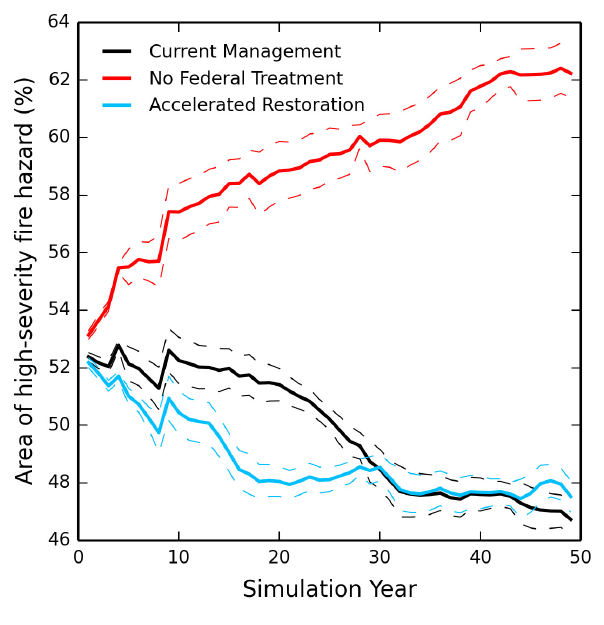
Fig. 6. Mean annual area (%) of potential high-severity fire (hazard) for current management, no federal treatment, and accelerated restoration scenarios over time across all forested potential vegetation types and ownerships. Broken lines indicate corresponding 95% confidence